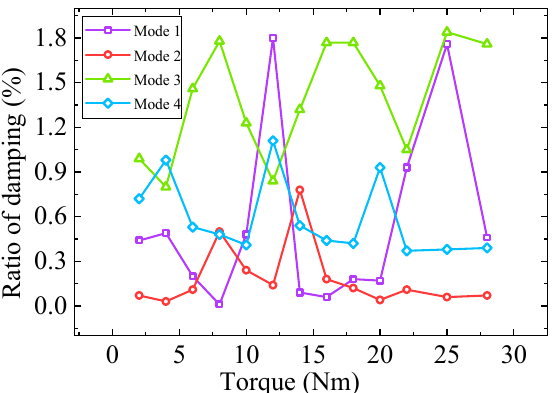
Figure 8. Experimental damping ratio depends on the pre ‐ tightening torque.